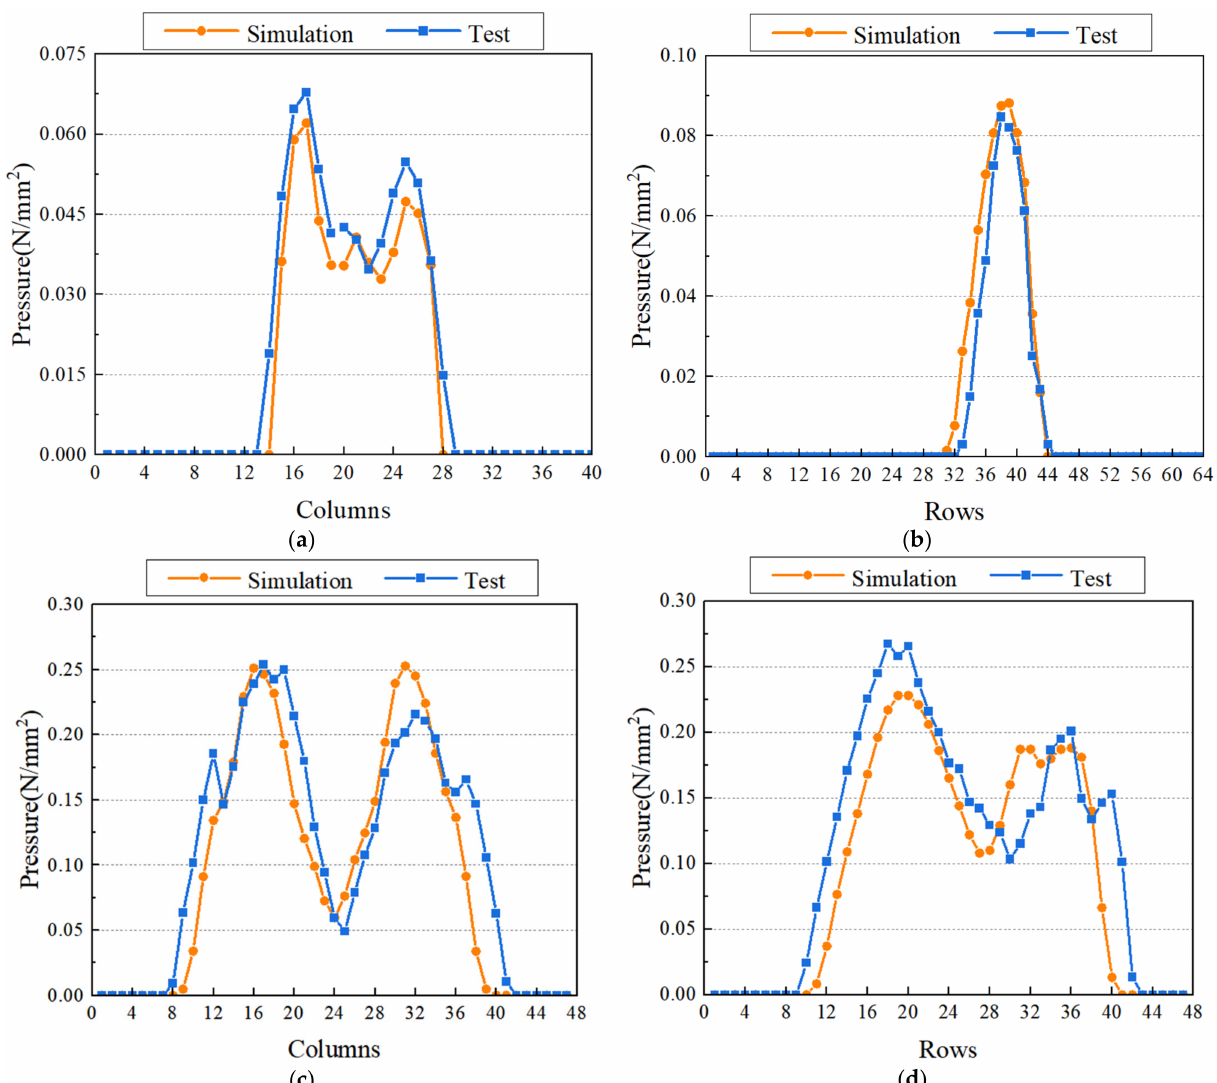
Figure 8. ( a ) Simulation and test curve comparison of transversal pressure distribution of backrest; ( b ) Simulation and test curve comparison of longitudinal pressure distribution of backrest; ( c ) Simu- lation and test curve comparison of transversal pressure distribution of cushion; ( d ) Simulation and test curve comparison of longitudinal pressure distribution of